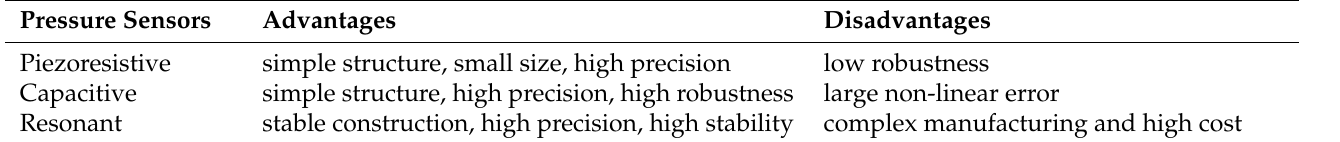
Table 3. Advantages and disadvantages of pressure sensors used for